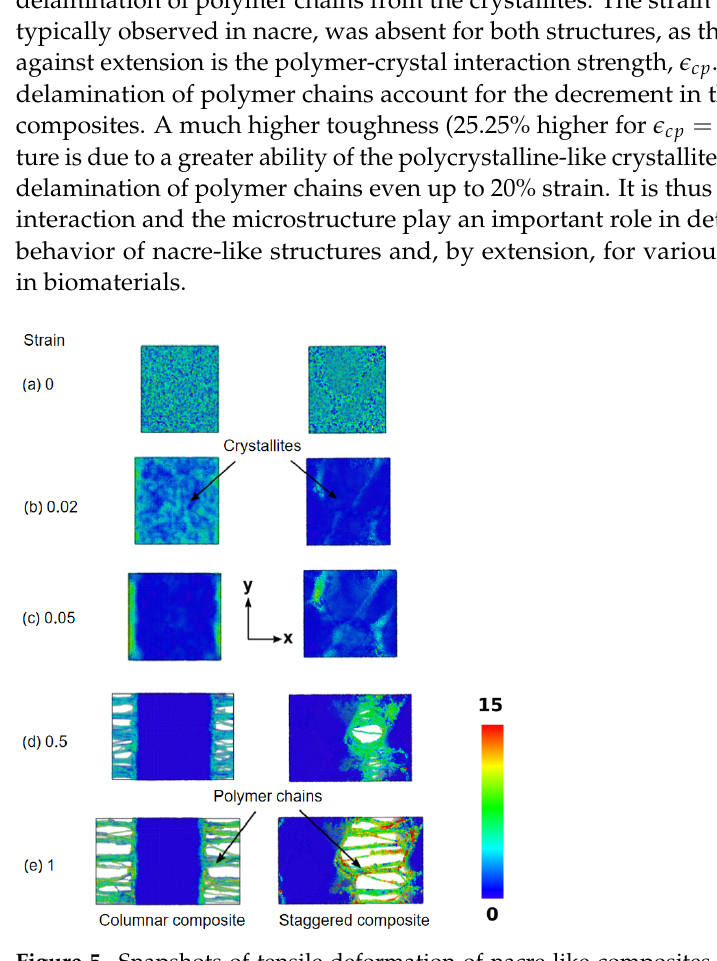
Figure 5. Snapshots of tensile deformation of nacre-like composites for increasing strain. Color coding represents the shear strain in the system at particular